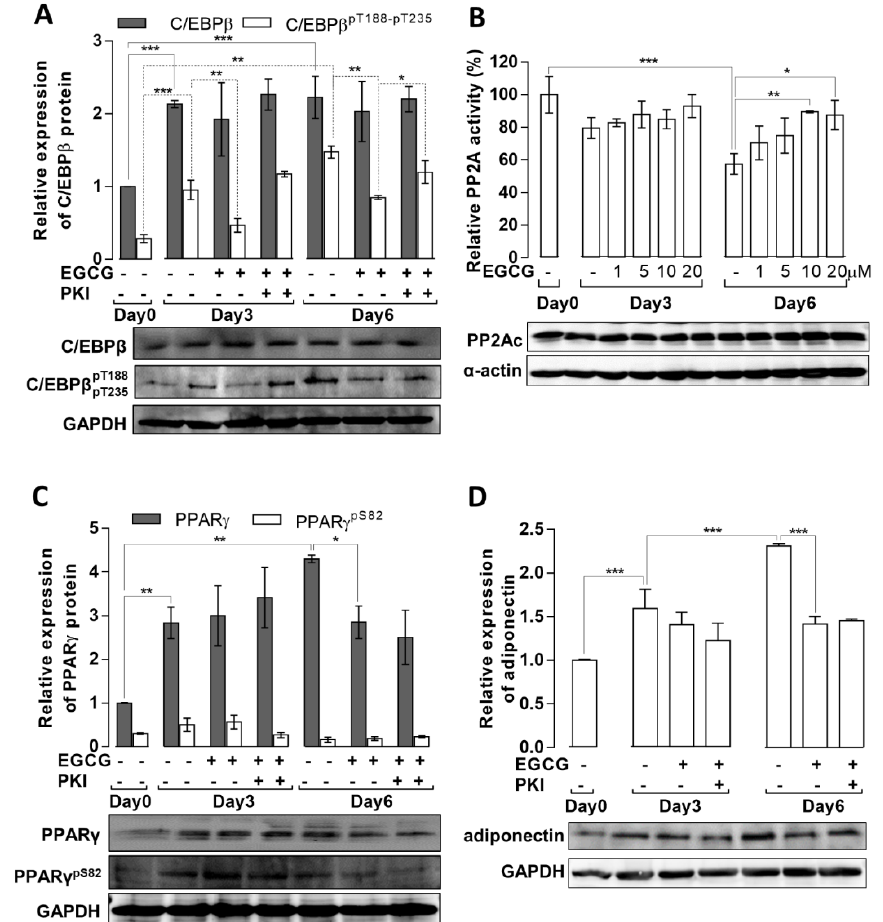
Figure 3. Expression and phosphorylation of C/EBP β , PPAR γ , and adiponectin, and changes in PP2A activity during the adipogenic differentiation of MSCs. MSCs were differentiated in the absence or presence of 20 µ M EGCG or 20 µ M EGCG plus 20 µ M PKI. On days 0, 3, and 6 of differentiation, cells were lysed and subjected to Western blot analysis or phosphatase activity assays, as described in the Materials and Methods section. ( A ) Expression and phosphorylation of C/EBP β detected with anti-C/EBP β and anti-C/EBP β p188/235 . ( B ) PP2A specific activity in cell lysates measured in the presence of 2 µ M PP1 inhibitor (inhibitor-2), using pMLC20 as substrate. Under the bar graph of phosphatase assay, Western blots of PP2A catalytic subunit from activity measurements are shown together with blots of α -actin, as a housekeeping protein. ( C ) Expression and phosphorylation of PPAR γ were detected with anti-PPAR γ and anti-PPAR γ p82/112 . ( D ) Expression of adiponectin assessed by anti-adiponectin antibody. In A, B, C, and D, representative Western blots are shown. Bar graphs represent densitometric analysis of the blots ( n = 3). Statistical analysis: two-way ANOVA; * p < 0.05, ** p < 0.01, *** p < 0.001; n.s.: